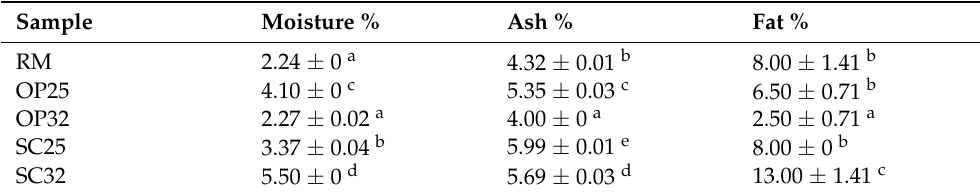
Table 1. Chemical composition of raw milk and amasi.